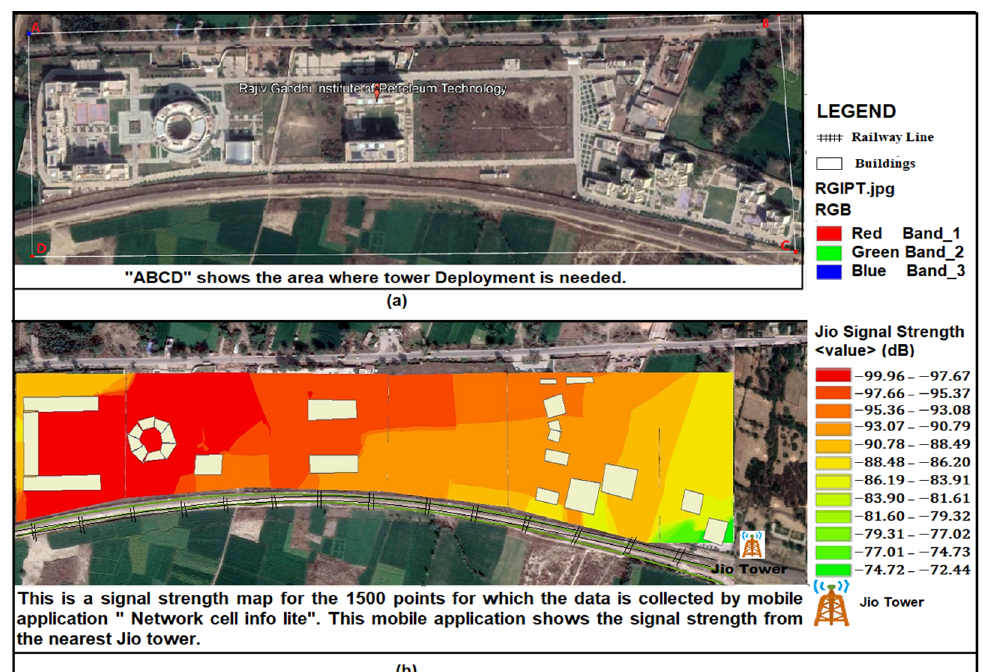
Figure 10. ( a ) Project Area of RGIPT campus, ( b ) Signal strength from nearest JIO cell phone tower at 1500 user locations on the RGIPT campus.